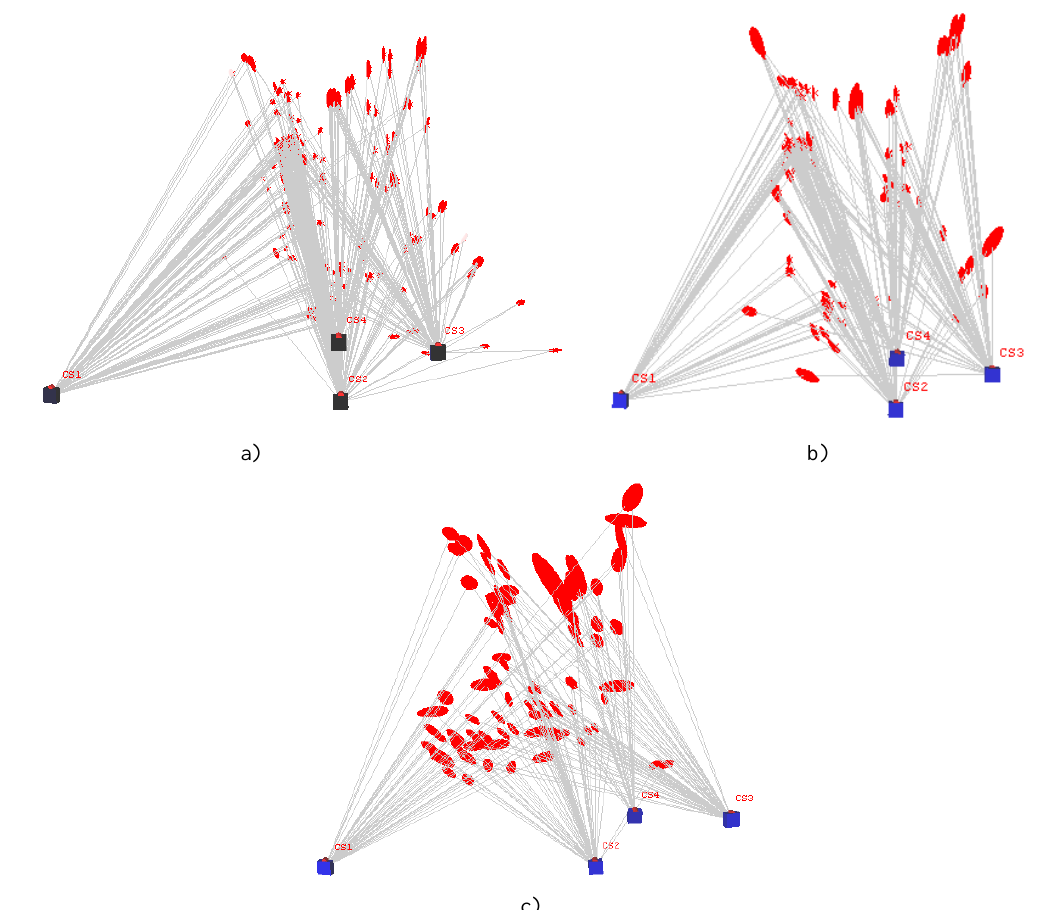
Figure.12. The bundle adjustment results with exaggerated error ellipsoids: a) SIFT guided matching; b) SURF guided matching; c) NCC guided matching.